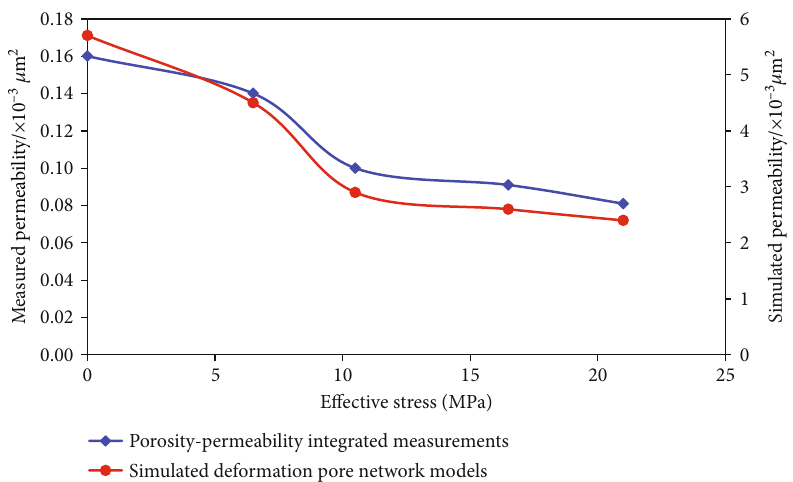
Figure 12: Relationship between permeability and e ff ective stress for porosity-permeability integrated measurements and simulated deformed digital